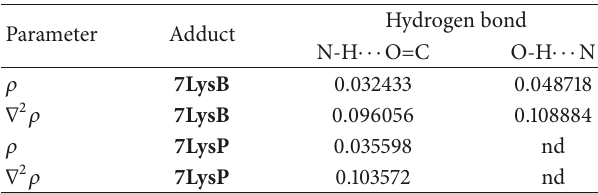
Table 2: Electron densities 𝜌 and Laplacian fields ∇ 2 𝜌 [e˚A] deter- mined for the 7Lys adducts with a hydrogen bond; nd: no